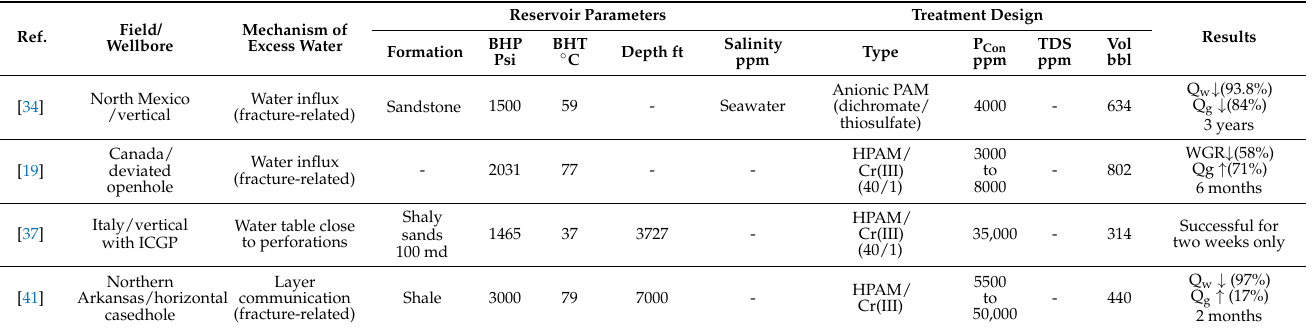
Table 2. HPAM/Cr(III)—water shutoff treatments in gas production wells (WSOGs). Ref.